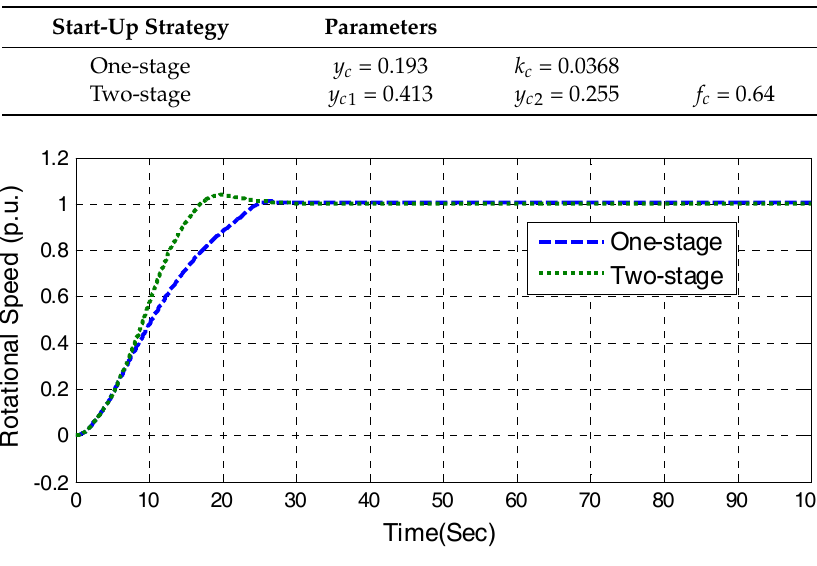
Figure 17. Rotational speed of traditional start-up strategies with Scheme B.